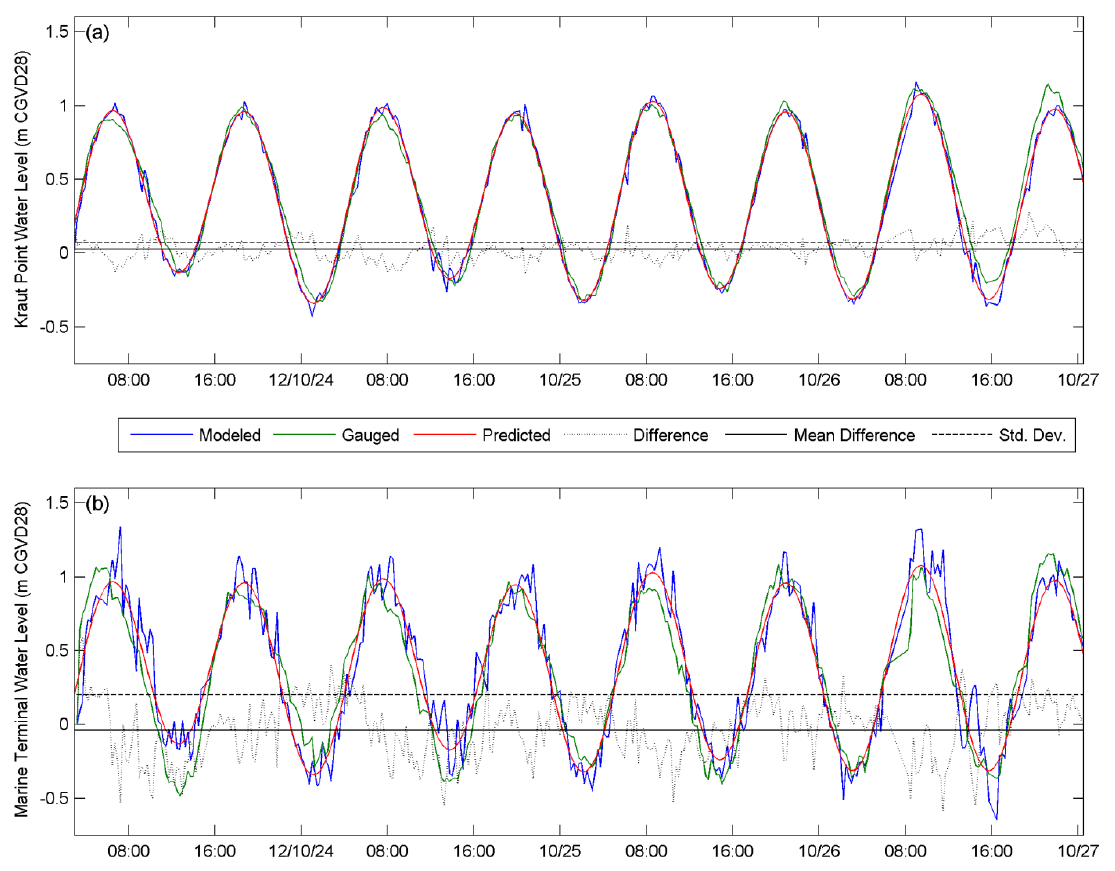
Figure 8. ( a ) Comparison of tide gauge observations with model results for the 27 m grid at Kraut Point (mean difference −2.8 cm, standard deviation 7.1 cm); ( b ) comparison of tide gauge observations with model results for the 3 m grid at the Marine Terminal (mean difference −3.8 cm, standard deviation 20.1 cm). Predicted tide used for the model boundary is plotted on both ( a ) and ( b